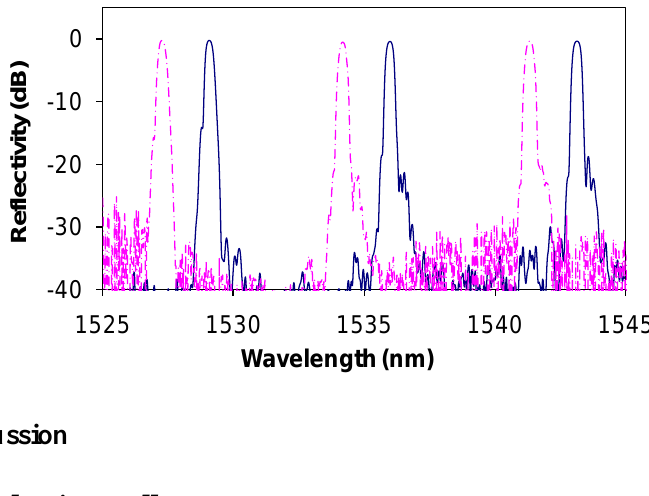
Figure 3. Reflection spectra of a FBG sensor array before (solid line) and after (dashed line) bonded onto the aluminum